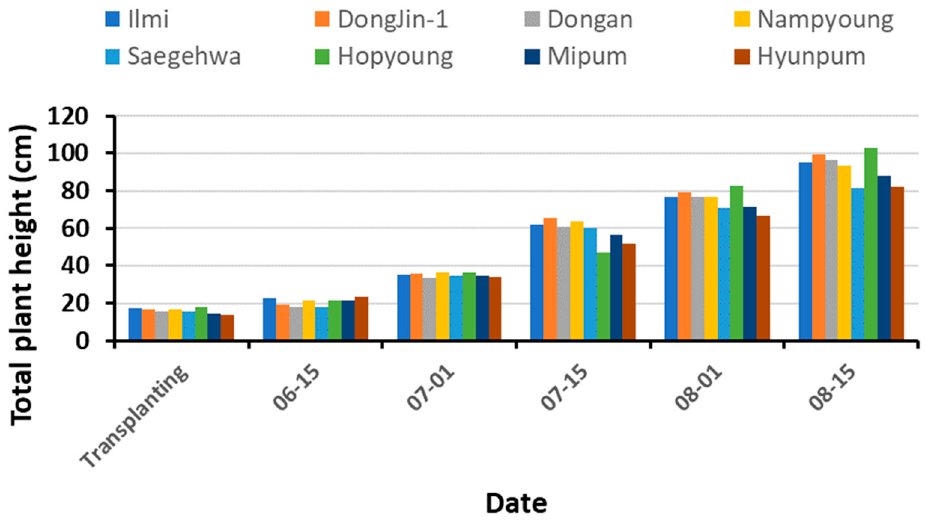
Figure 3. Plant height at transplantation date, mid-June, early July, mid-July, early August, and mid-August for all eight rice cultivars used in this study.